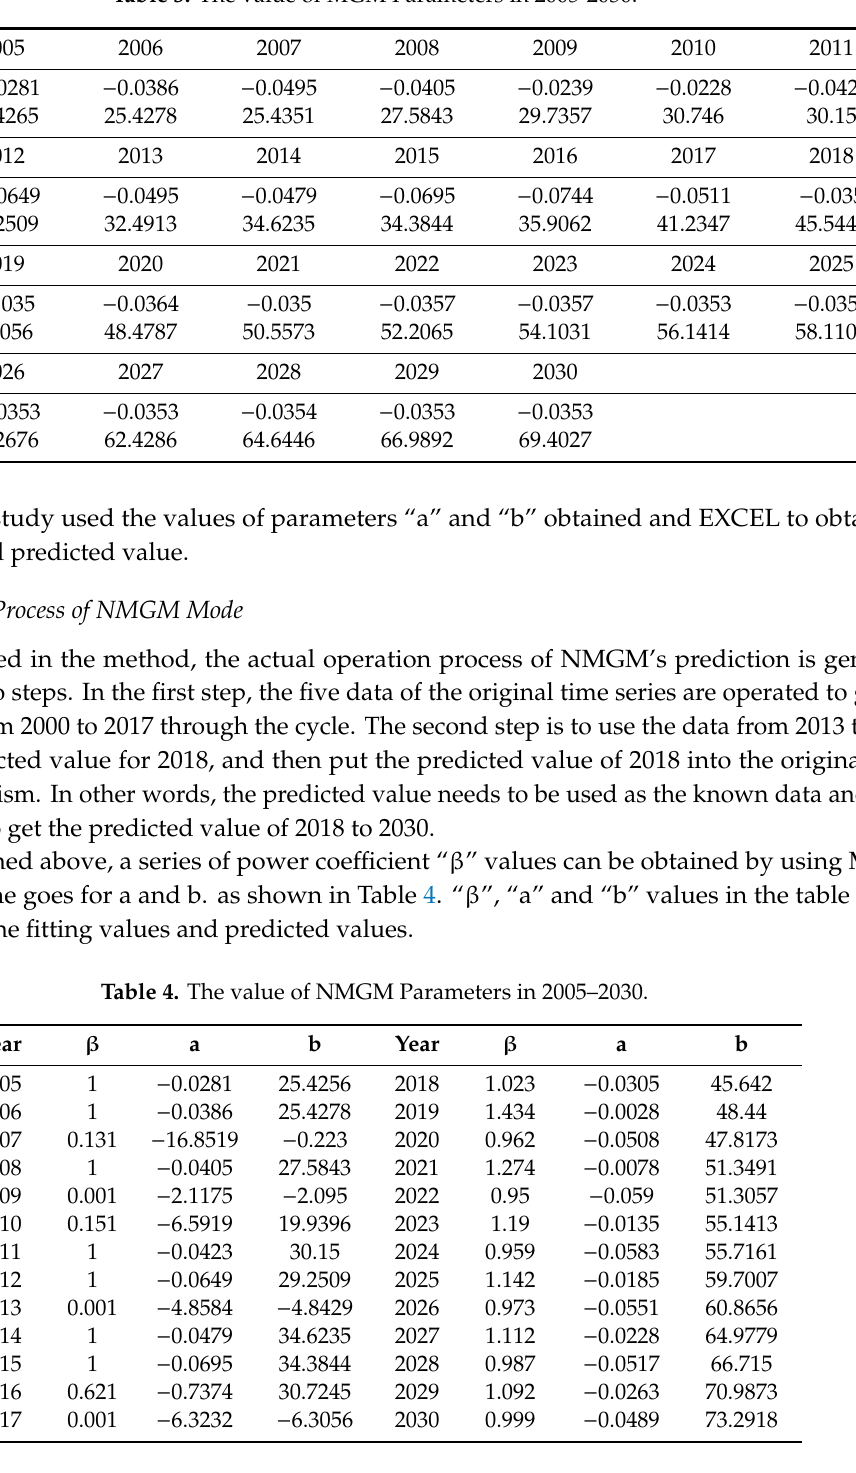
Table 3. The value of MGM Parameters in 2005-2030.